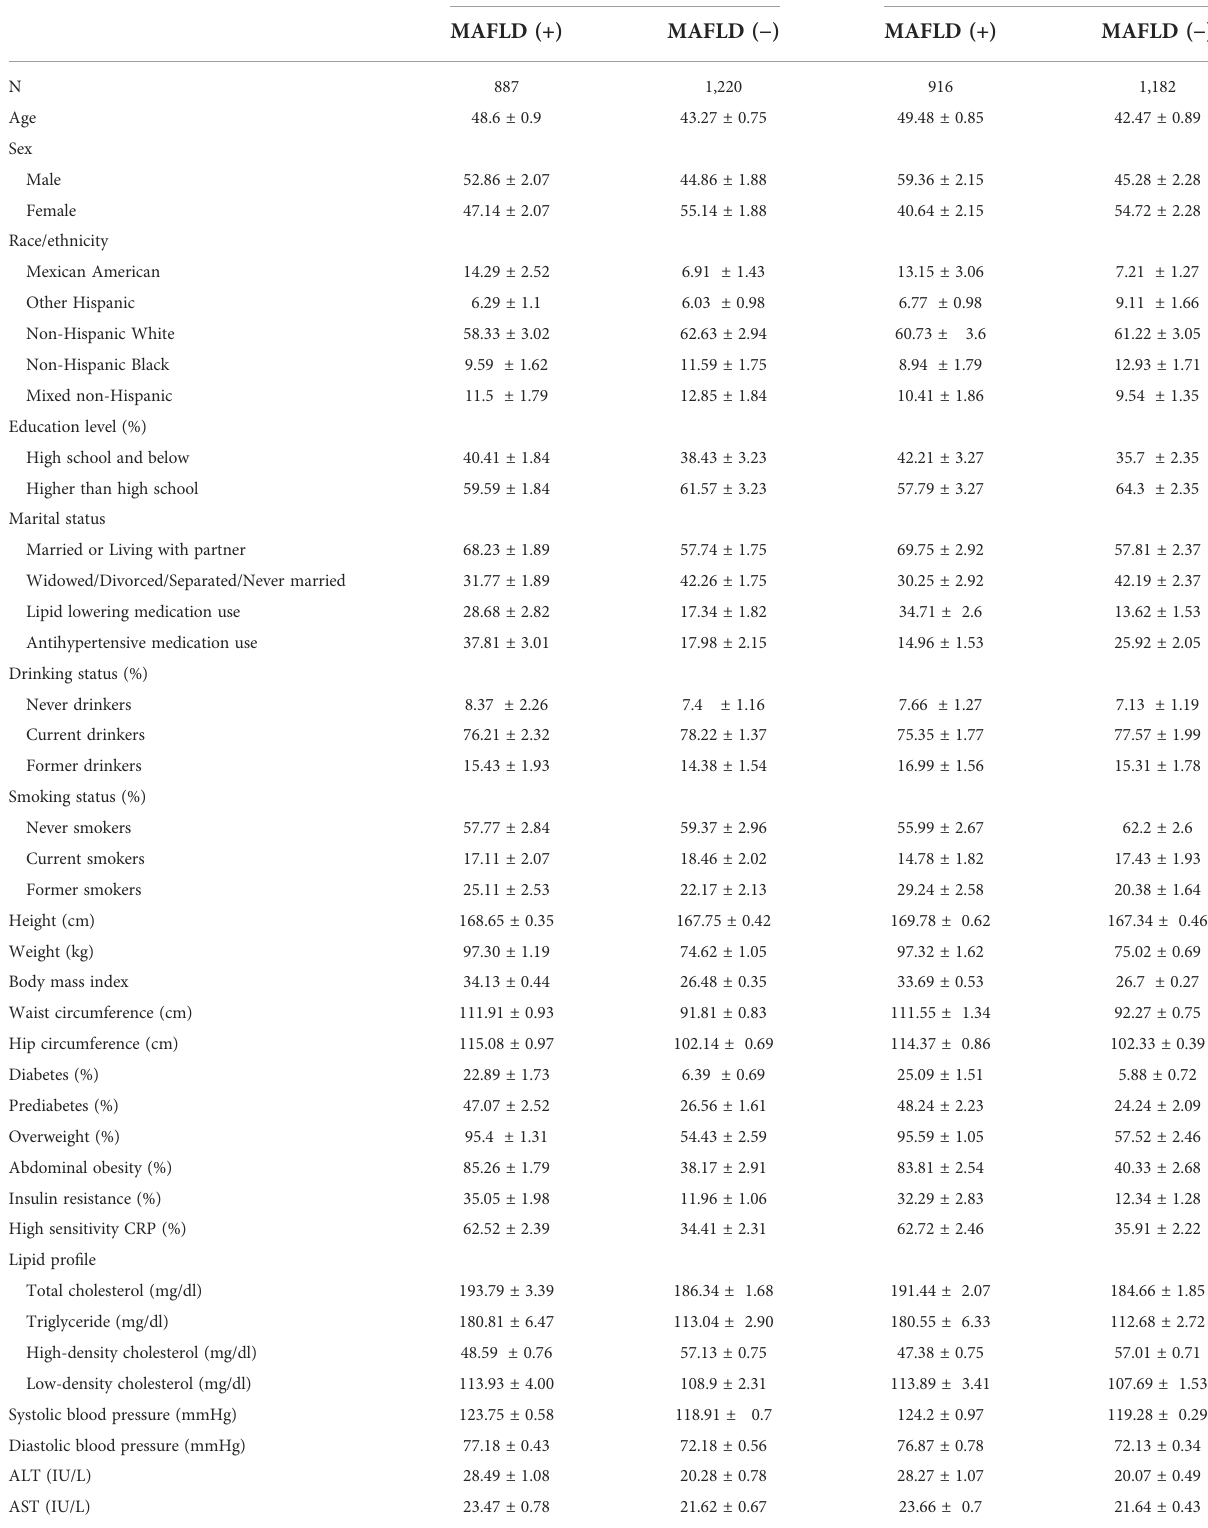
TABLE 7 Baseline characteristics for the training and validation groups by MAFLD